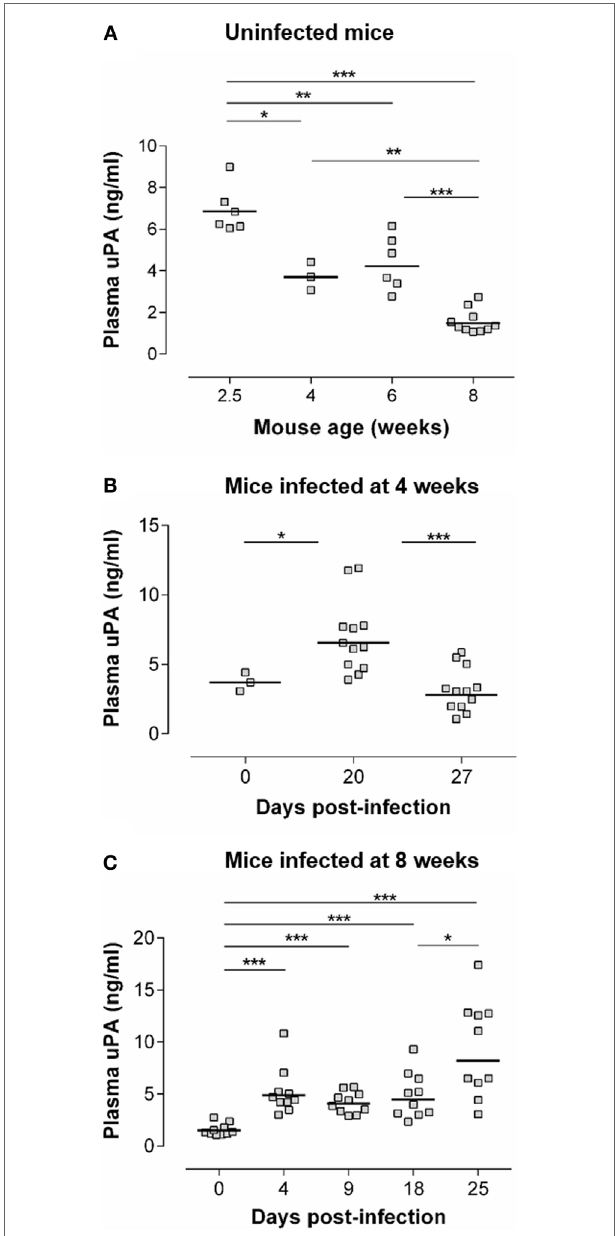
FigUre 1 | uPa levels are increased during the acute phase of T. cruzi infection . (a) uPA plasma levels were determined by ELISA in WT C57Bl/6 mice of the indicated age. (B) Four-week-old WT C57Bl/6 mice were inoculated s.c. with 50 trypomastigotes. uPA plasma levels were determined prior to infection (dpi 0) or at dpi 20 and 27. (c) Eight-week-old WT C57Bl/6 mice were inoculated s.c. with 100 trypomastigotes. uPA plasma levels were determined at dpi 0 or at dpi 4, 9, 18, and 25. (a–c) Statistically significant differences are indicated with * p ≤ 0.05, ** p < 0.01, and *** p < 0.001 (Mann–Whitney U